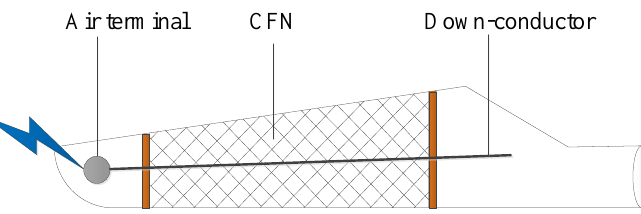
Figure 1. Structure of a wind turbine blade cover with a carbon fiber net (CFN).